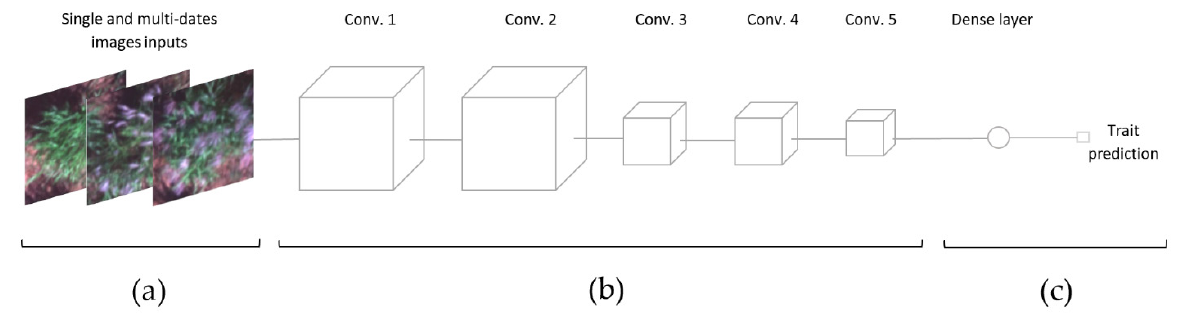
Figure 3. Diagram of the custom CNN architecture utilized to assess flowering time, culm length, and biomass yield in Miscanthus. ( a ) Input single- or multi-date image chips with varying numbers of features, as described in Table S1. ( b ) Backbone feature generator and ( c ) regressor head for trait prediction.